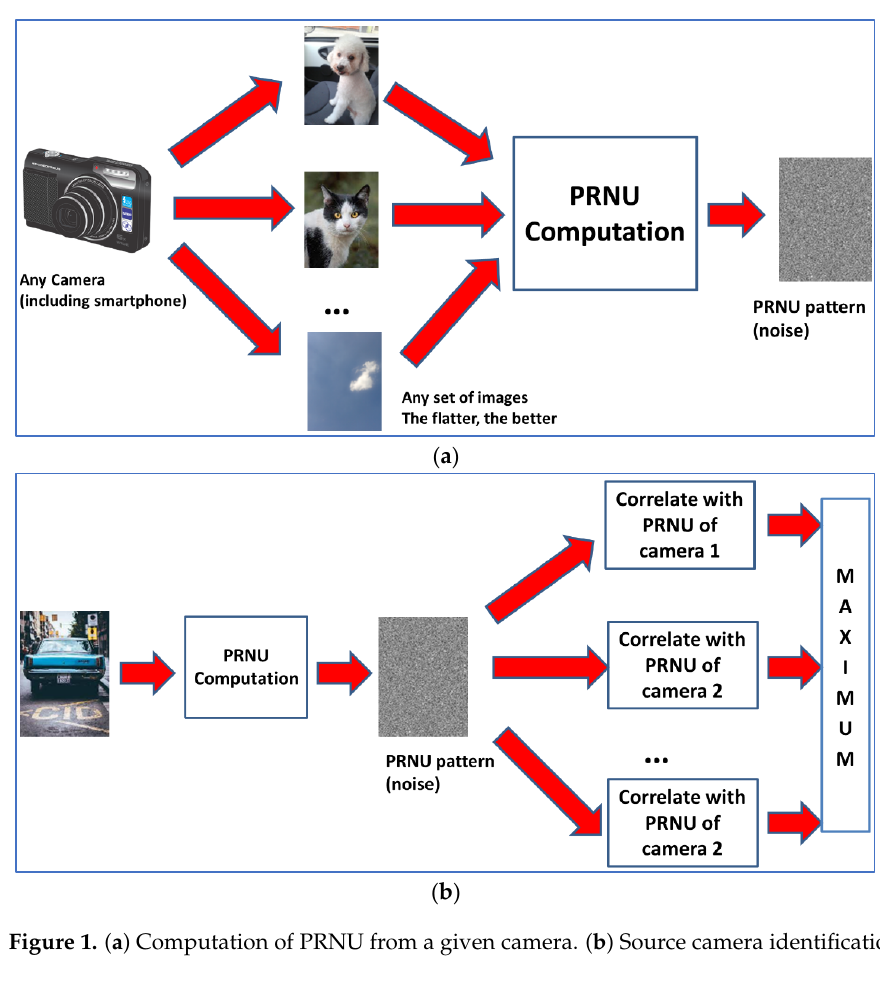
Figure 1. ( a ) Computation of PRNU from a given camera. ( b ) Source camera identification.